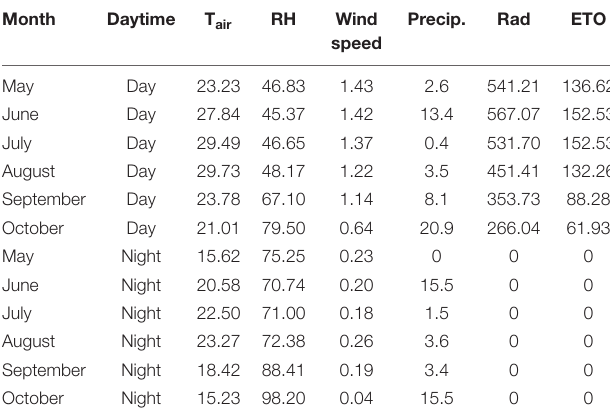
TABLE 1 | Average values of air temperature (T air , ◦ C), relative humidity (RH, %), wind speed (m s − 1 ), cumulative precipitations (Precip.), average radiation (Rad,